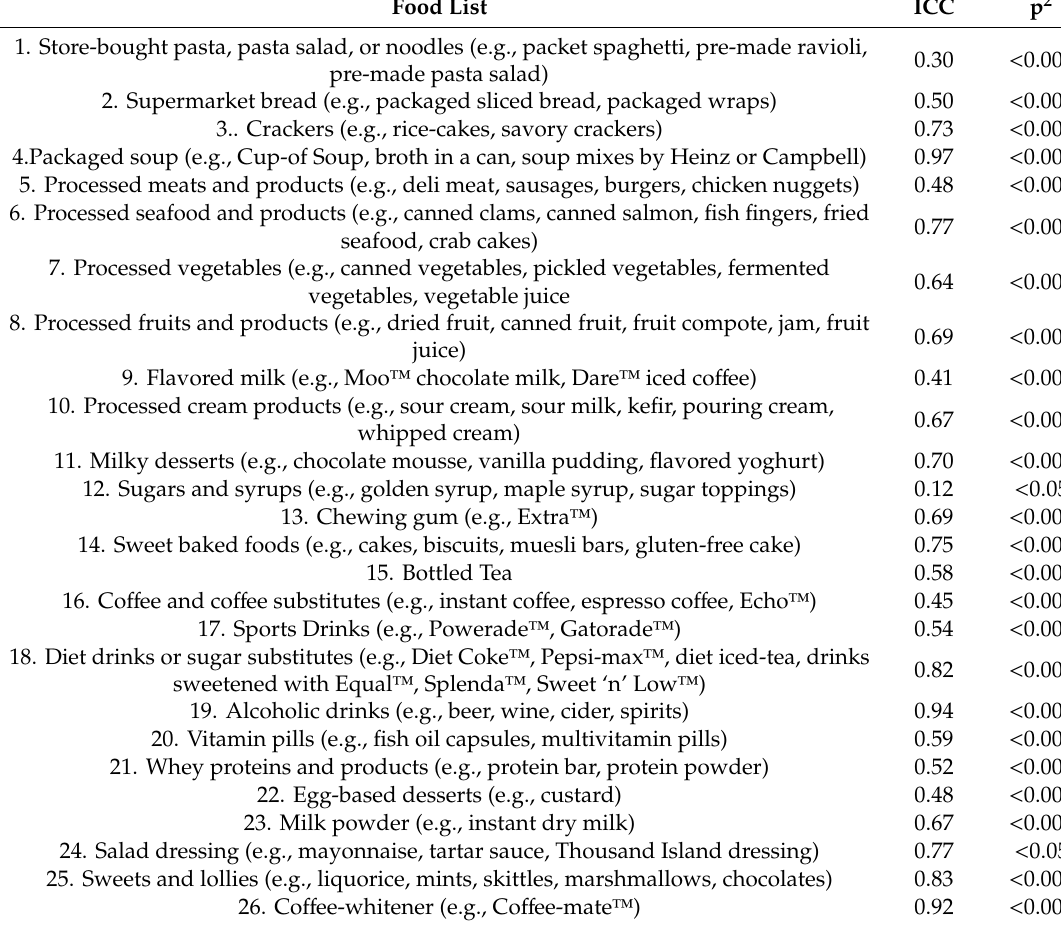
Table 5. Intra Class Correlation coe ffi cients (ICC) for food lists in part 2 food additive survey. Food List ICC p